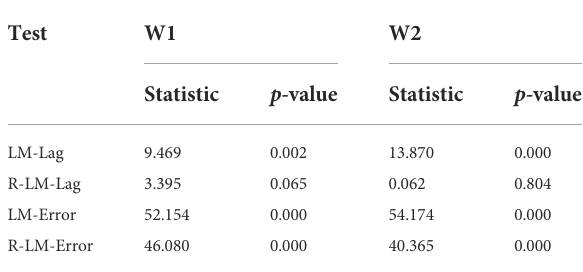
TABLE 6 LM test results. TABLE 7 Spatial econometric model regression